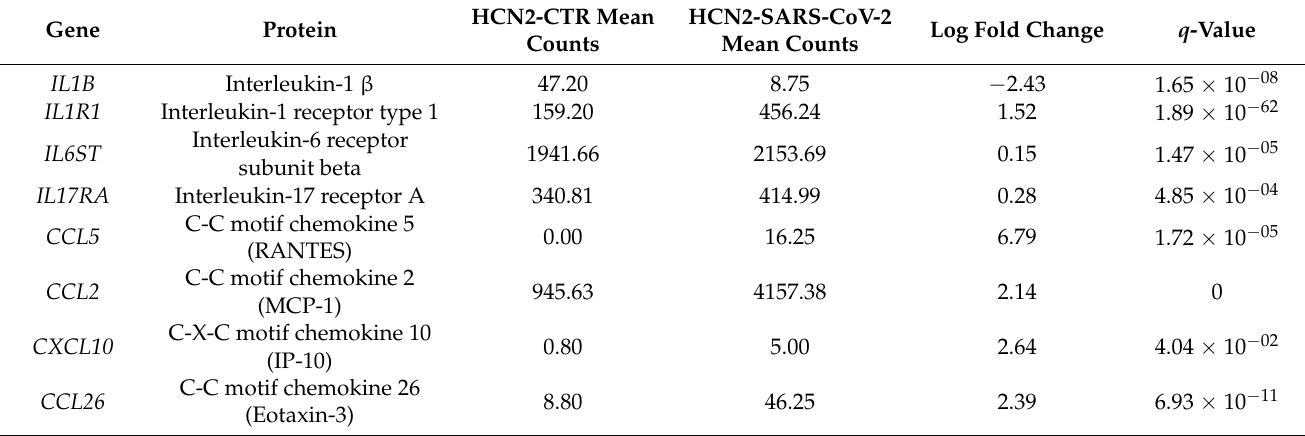
Table 3. DEGs encoding for cytokines/chemokines and their receptors.